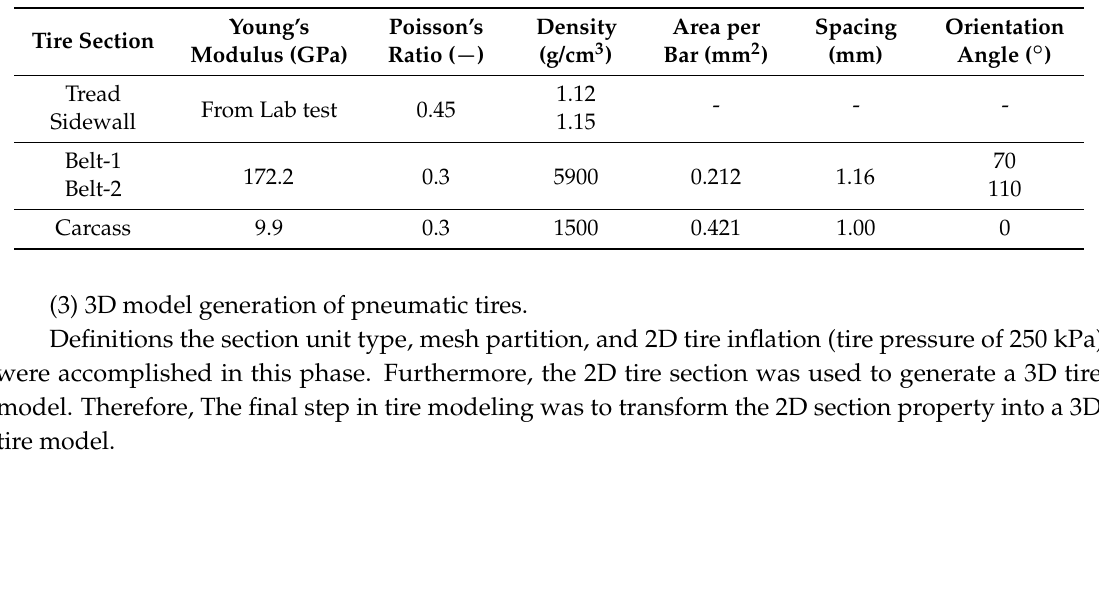
Table 2. Description of material properties used in the model